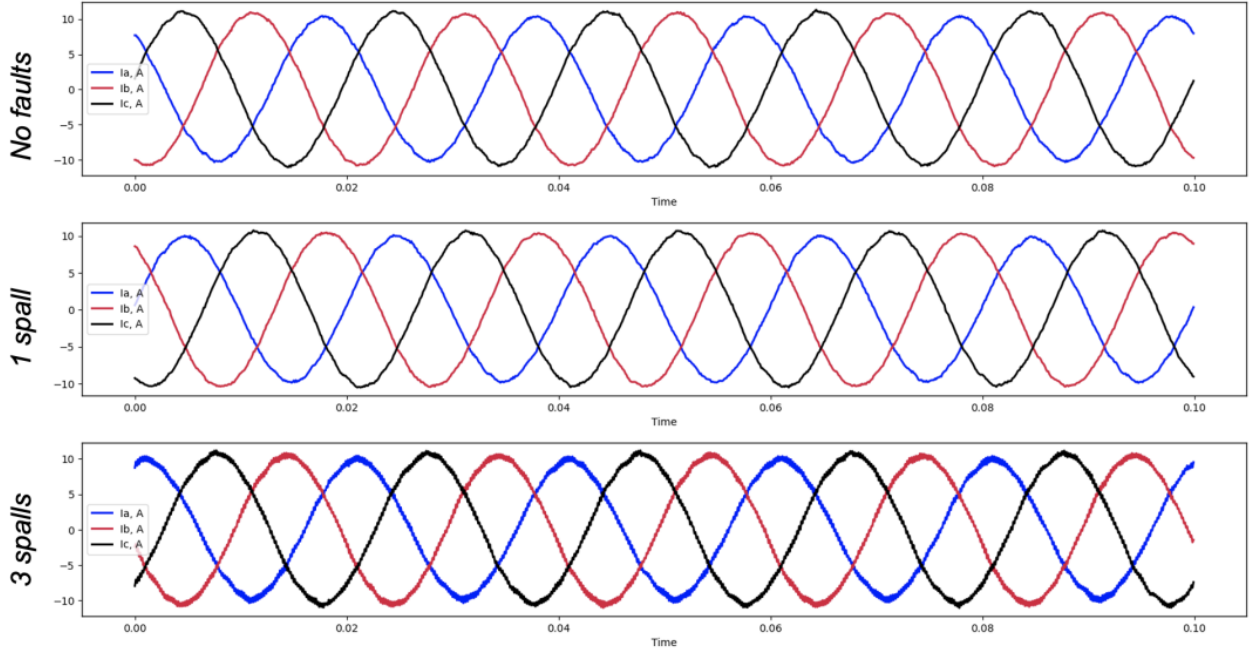
Figure 3. Current signals for the bearing without faults, the bearing with one spall and the bearing with three spalls.